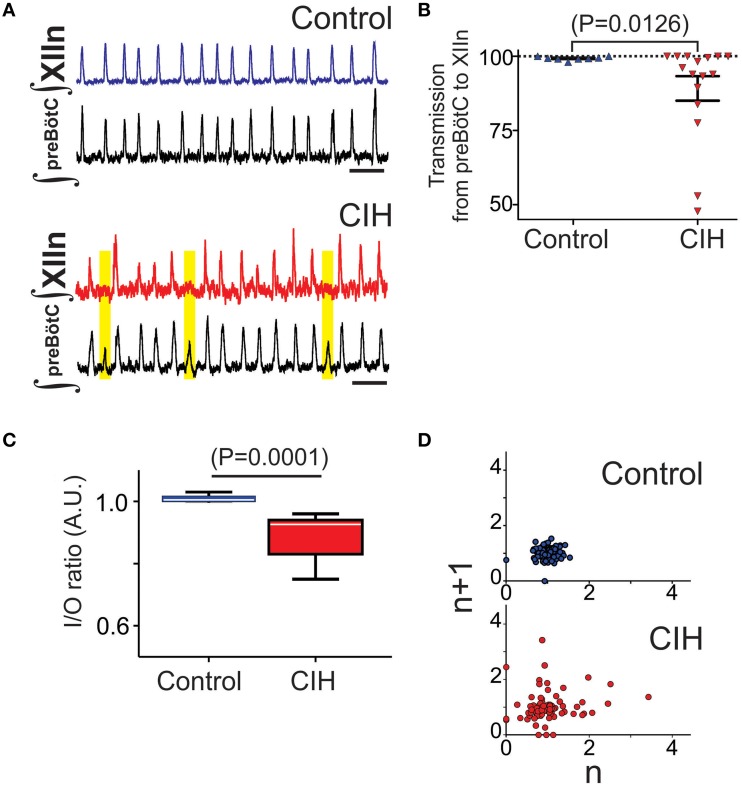
CIH causes a mismatch between preBötC network bursting and the XIIn and disrupts the typically tight input-output relationship. (A) Paired recordings of integrated preBötC and XIIn network rhythms from an individual control slice demonstrating the typical one-to-one burst relationship between premotor rhythm generator and the motor nucleus (top). Following CIH, network activity from the preBötC intermittently fails to produce activity in the XIIn (bottom). Yellow boxes highlight mismatch. Scale Bar: 10 s. (B) Transmission from preBötC to XIIn is reduced following CIH (nCIH = 16, ncontrol = 10). Furthermore, the CIH group exhibited a larger variance in rate of intermittent transmission failure compared to the control group (F-ratio = 690, P < 0.001). (C) When transmission from preBötC to XIIn was <90% following CIH, the I/O ratio revealed that CIH disrupts the I/O relationship between the premotor rhythm generator and the motor pool normally observed in control (F-ratio = 51.63, P < 0.0001). (D) Representative poincare maps of the I/O ratios illustrating that CIH also disrupted the normal predictability of I/O relationship. The dispersion in both SD1 and SD2 was different between control and CIH (see text).